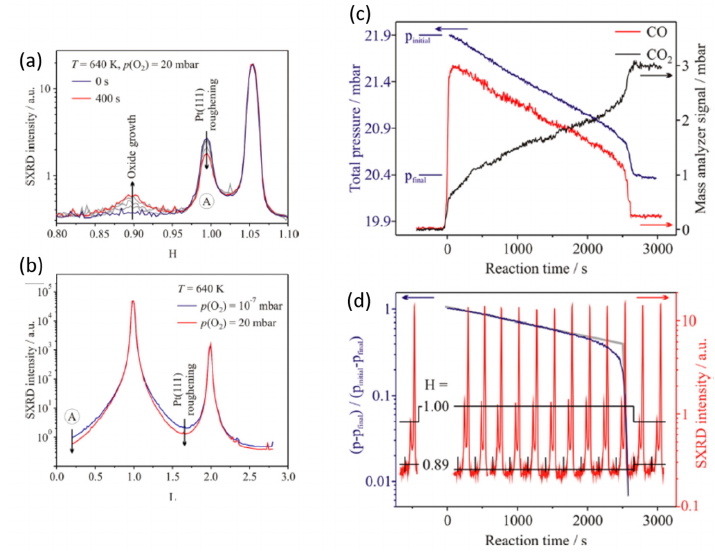
Figure 6. ( a , b ) Oxidation of the Pt(111) surface at 640 K as viewed by SXRD in two crystallographic directions (H and L) of reciprocal space showing both the Bragg reflection due to the growth of a α -PtO 2 surface oxide ( a ) and the effects due to the roughening of the underlying Pt surface that accompanies the formation of the surface oxide; ( c ) mass spectrometry during CO oxidation at elevated pressure (O 2 /CO initial = 1/6) as a function of time; ( d ) “ H ” scans (red) collected during the CO oxidation experiment shown in ( c ) along with the variation of total pressure of the system (blue) and the two separate kinetic regimes for CO oxidation (grey lines) observed as a function of changing O 2 /CO ratio. Reproduced with permission from J. Phys. Chem. C 2013 , 117 , 9932–9942 [124]. Copyright 2013, American Chemical